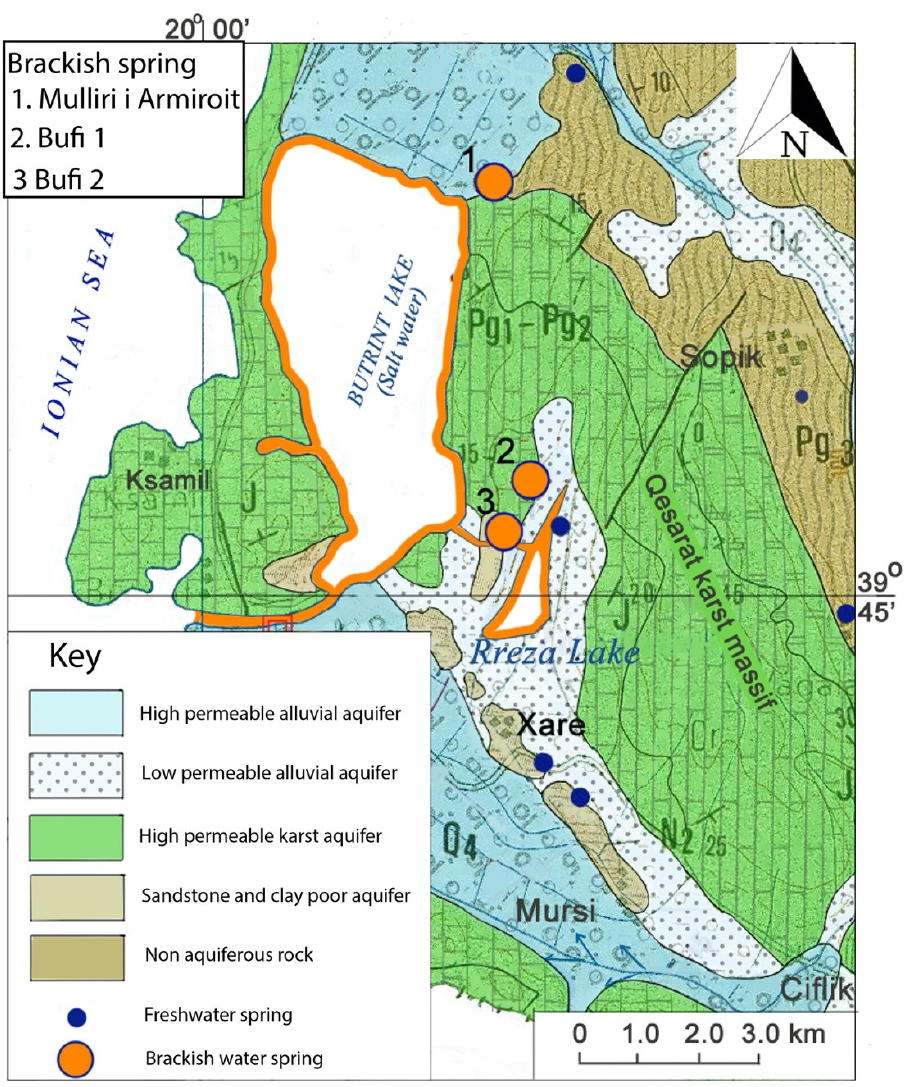
Figure 10. Hydrogeological map of the Butrint area (modified after [33]). Table 3. Main characteristics of brackish cold karst springs of the Ionian coastal areas of Albania.